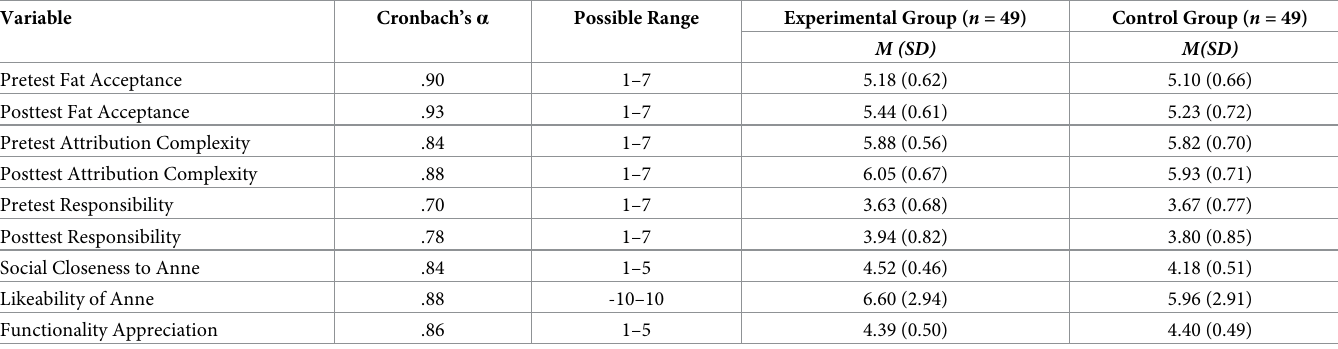
Table 2. Participants’ scores on the measures at pretest and